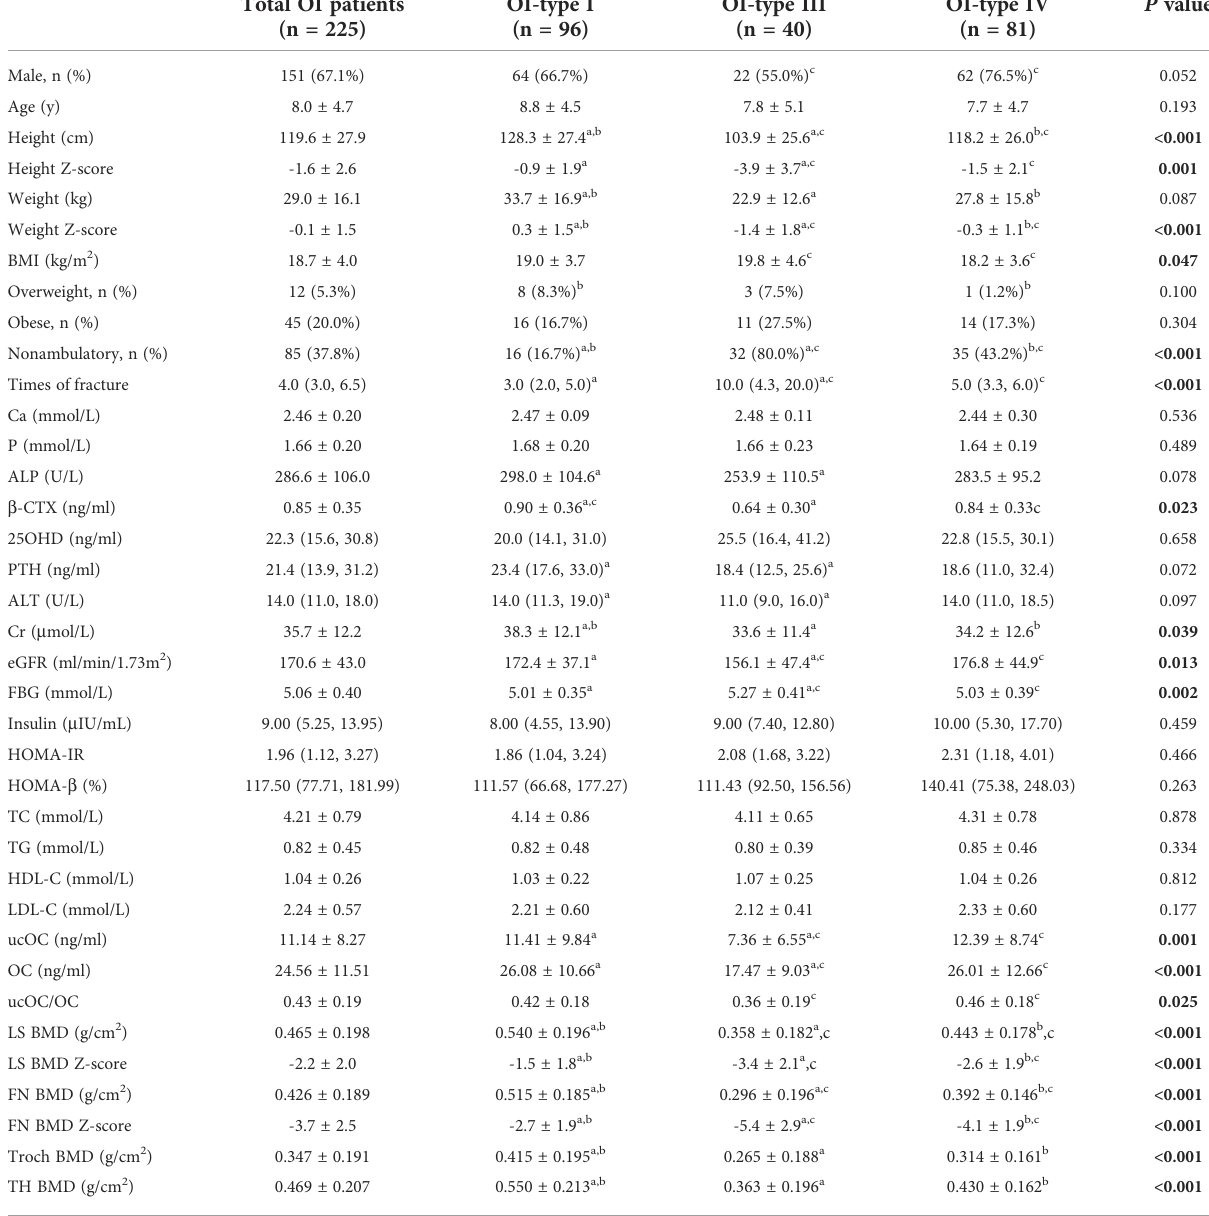
TABLE 2 Clinical characteristics of OI patients with different clinical classi fi